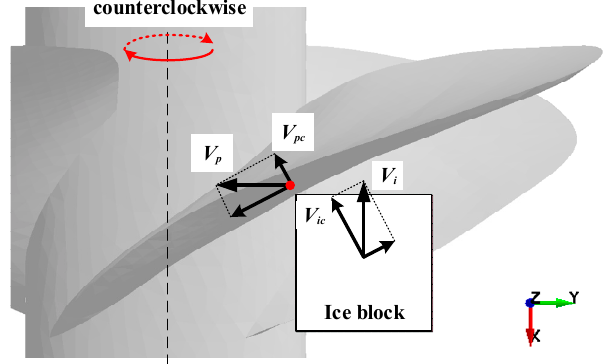
Figure 15. Schematic diagram of the speed during propeller–ice impacting process.